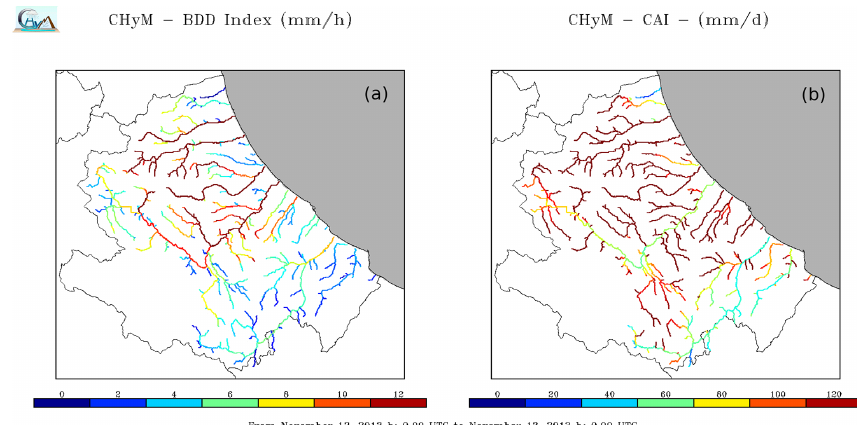
Figure 12. CS03 24h maps of the BDD index (a) and the CAI (b) obtained for 12 November 2013, by forcing CHyM with observed rainfall data. Warmer colours indicate river segments with higher flood stress. In both figures, the Abruzzo region drainage network, belonging to the Central Apennine District, is highlighted.